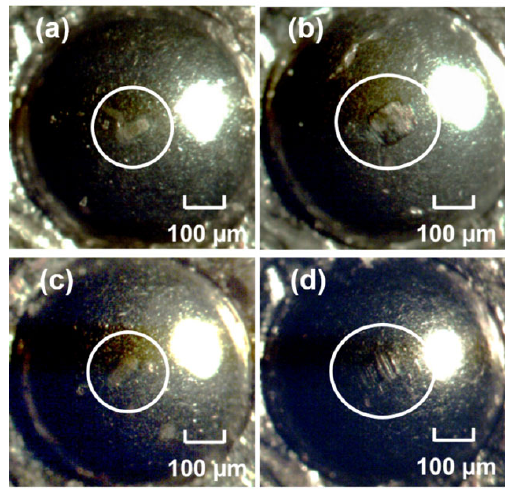
Fig. 8 Optical images of worn balls after lubricated with (a) MO at room temperature, (b) MO at 100 ºC, (c) 1 wt% DCi+MO at room temperature, and (d) 1 wt% DCi+MO at 100